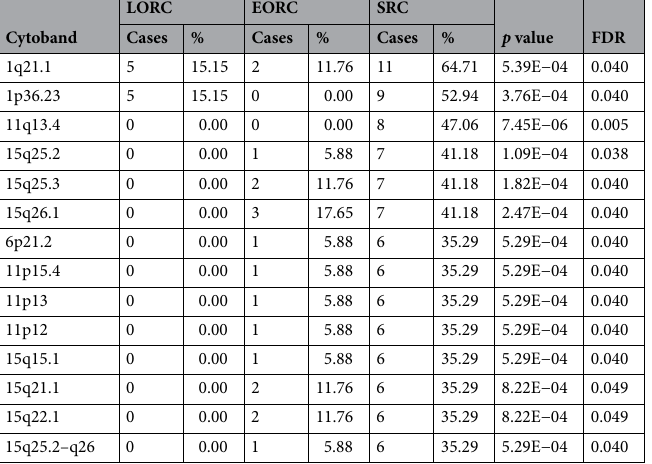
Table 4. Losses occurring with statistically significantly different frequencies in the three groups. EORC, early-onset rectal cancer; FDR, false discovery rate; LORC, late-onset rectal cancer; SRC, synchronous rectal